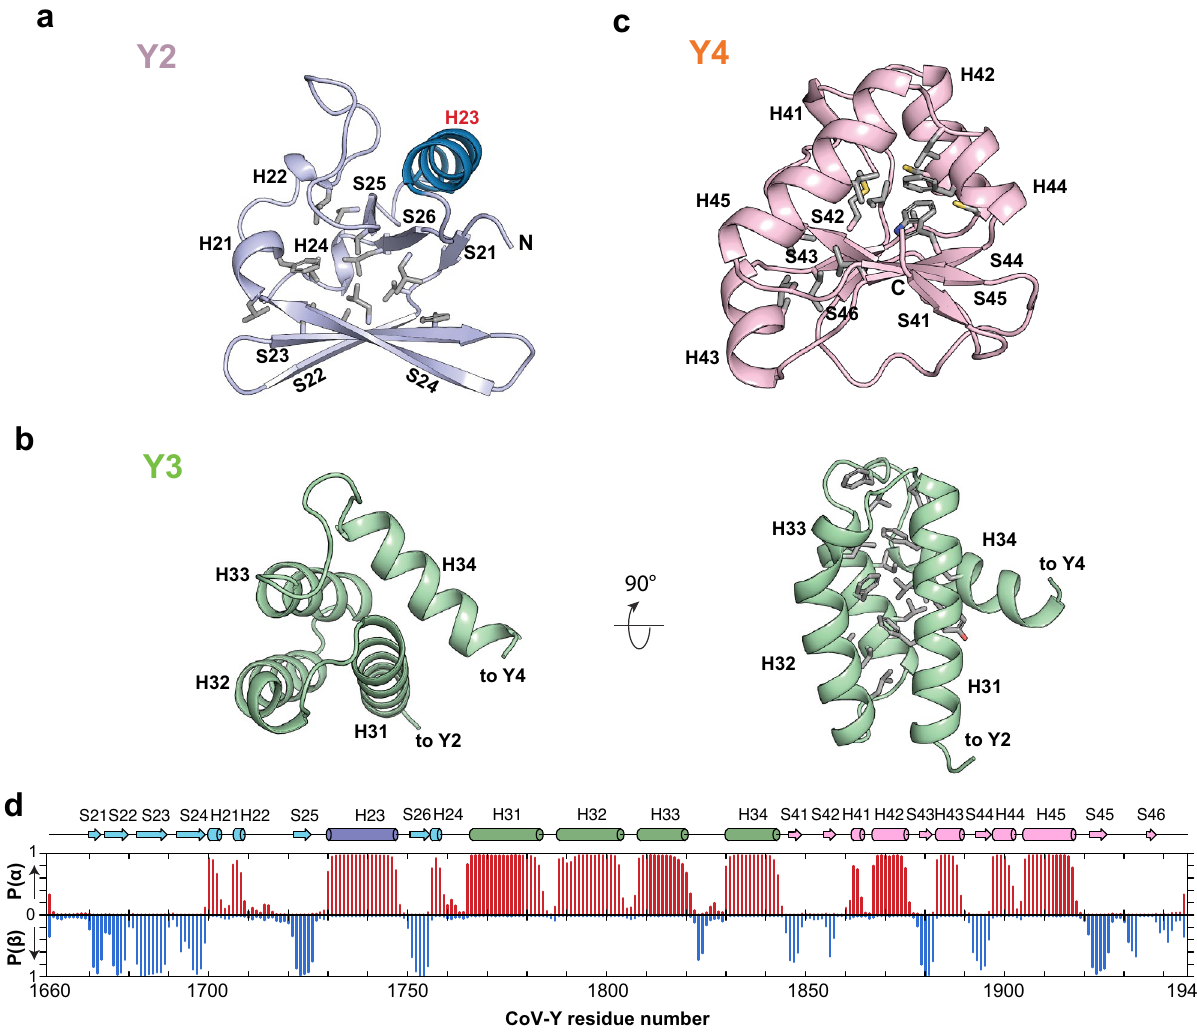
Figure 2. The CoV-Y domain comprises three distinct subdomains. ( a ) Ribbon diagram of the Y2 subdomain. Residues lining the internal hydrophobic core are shown in stick representation. ( b ) Ribbon diagram of the Y3 subdomain. A cluster of hydrophobic and aromatic residues in the central core of the helix bundle is shown in stick representation. ( c ) Ribbon diagram of the Y4 subdomain. The hydrophobic residues in its core are shown in stick representation. ( d ) Secondary structure propensity of the CoV-Y domain in solution derived using TALOS-N 58 as shown previously 26 . Probabilities of occurrence for helices [P(α)] and β-sheet [P(β)] are shown in red and blue, respectively. The corresponding secondary structure elements from the X-ray structure of the CoV-Y domain are shown across the top as cylinders (helices) and arrows (β